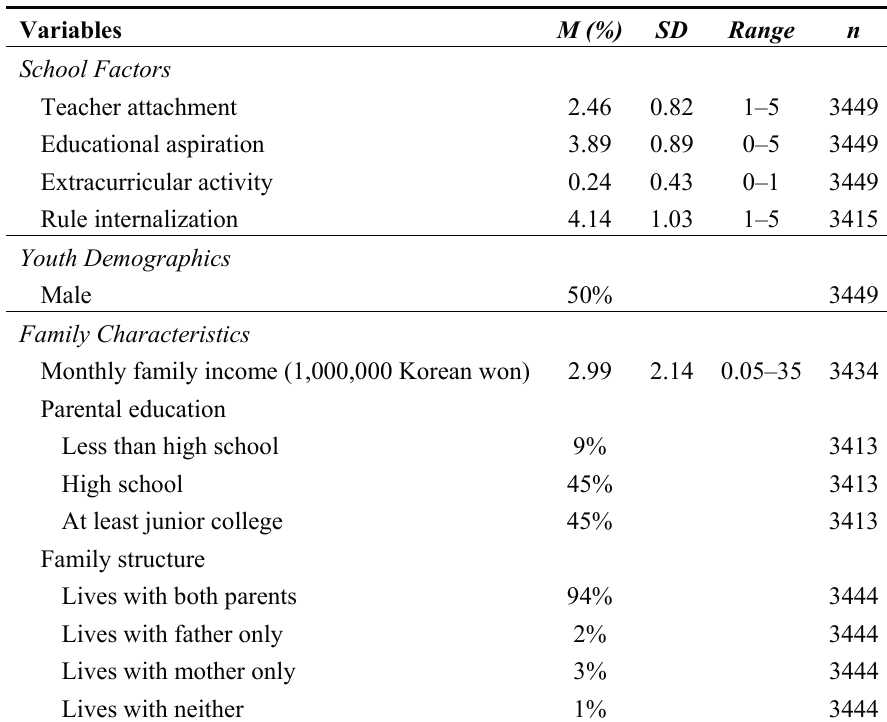
Table 1. Descriptive statistics at baseline.